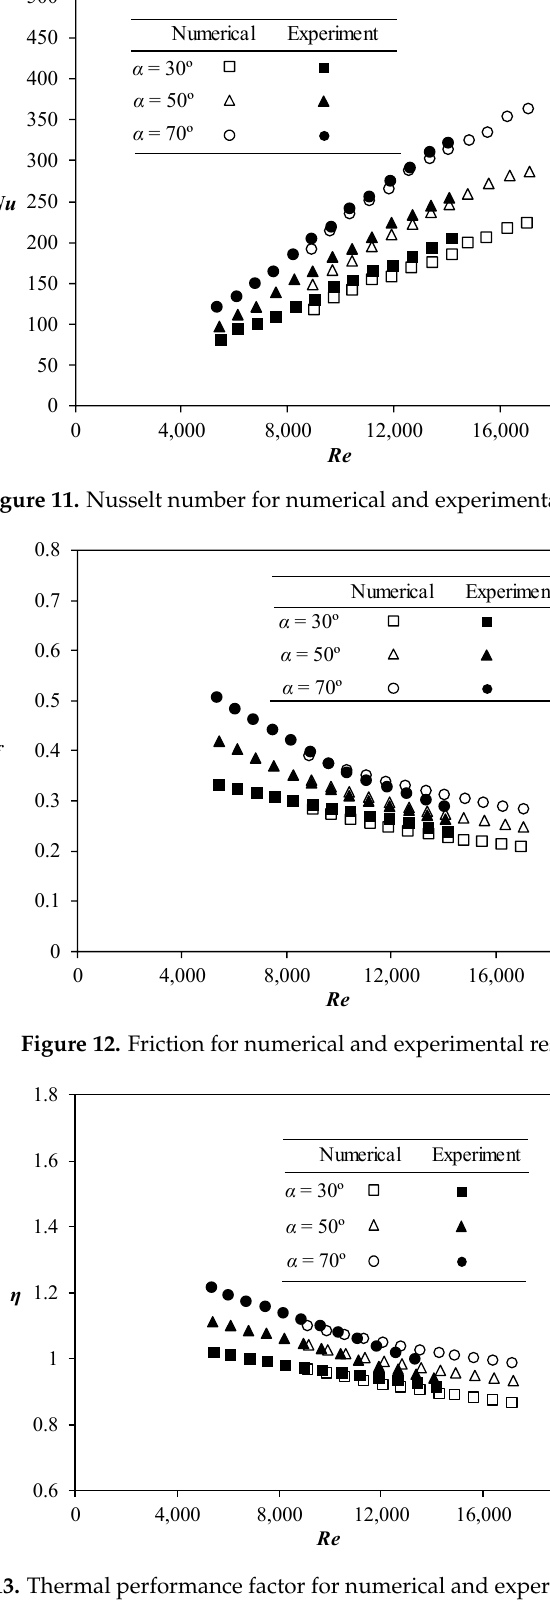
Figure 13. Thermal performance factor for numerical and experimental results.